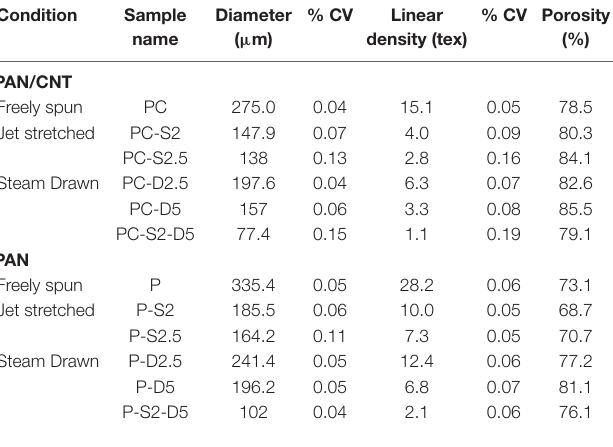
some fibrils and crystalline domains to rearrange and reorganize new domains, introducing new voids in the structure. Liu et